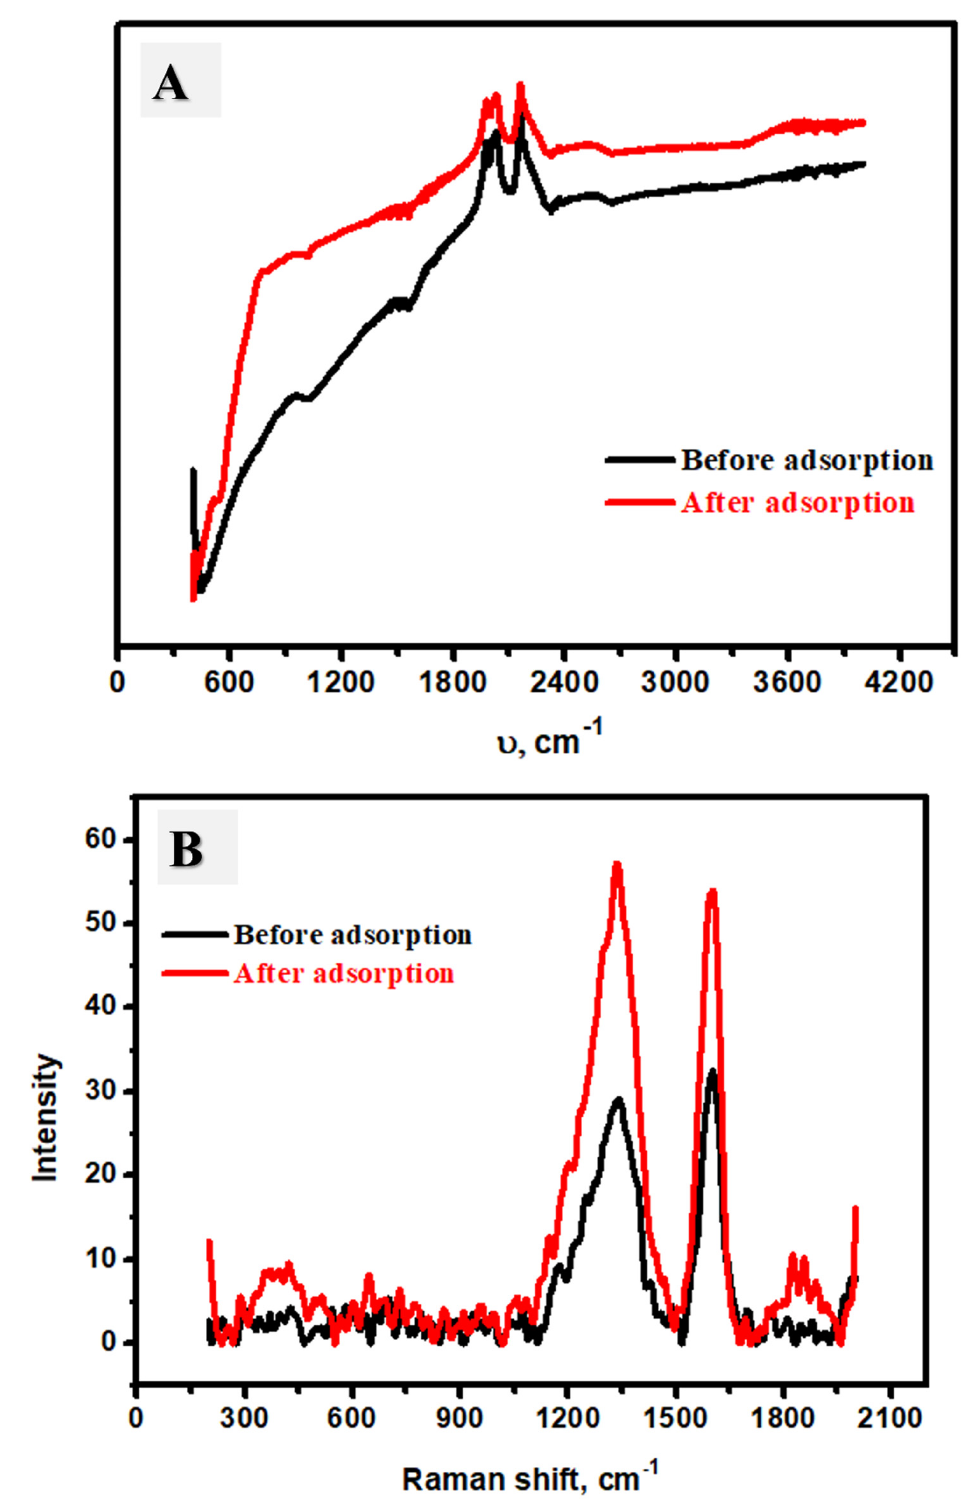
Figure 8. FT-IR ( A ) and Raman spectroscopy ( B ) of the prepared Fe(0)@AC adsorbent with (red lines) and without (black lines) adsorption experiments. and without (black lines) adsorption